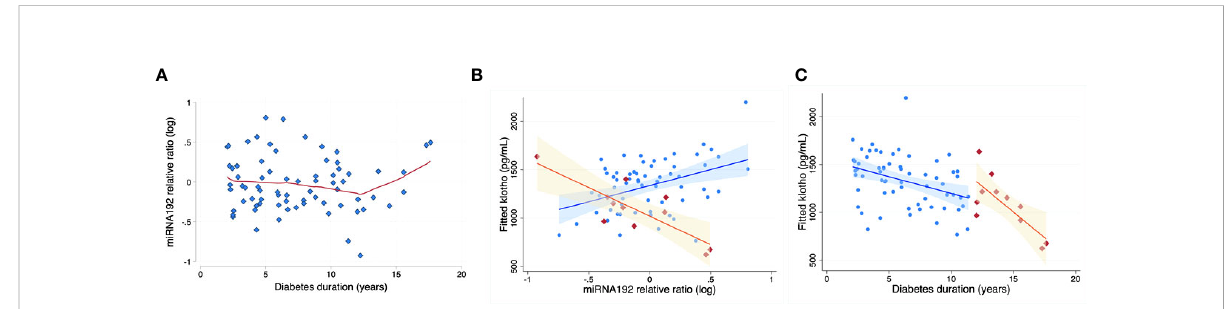
FIGURE 2 miR-192 levels and KL levels with diabetes duration. miR-192 levels are relatively stable with disease <12 years duration. There is an “ in fl ection point ” at ~12 years, with miR-192 levels increasing after that with increased duration of diabetes (A) . Red line is based on LOWESS (locally weighted scatterplot smoothing) regression. Correspondingly, in a predictive model using miR-192 level and adjusted for age and sex (B) , KL levels decrease more steeply after 12 years of duration of diabetes (orange segment; shaded area represents 95% con fi dence bands). Blue segment demonstrates the relationship in children with diabetes duration of less than 12 years. (C) shows signi fi cant inverse relationship between miRNA-192 and KL levels with prolonged duration of diabetes (>12 years of diabetes; orange, r 2 = 0.89,